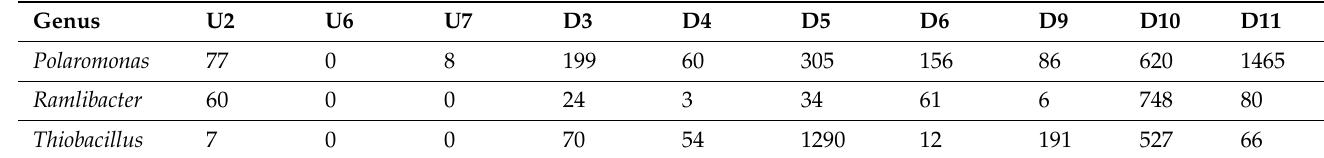
Table 11. Greatest bacterial abundance by genus for the Zone E downstream sites (D3, D4). These sample sites showed diverse genera, which corresponded to the diverse characteristics of the different sample sites. Polaromonas inhibited the environments with extremely low temperatures, whilst the species belonging to genera Ramlibacter degraded isoprene and/or were methanotrophic.